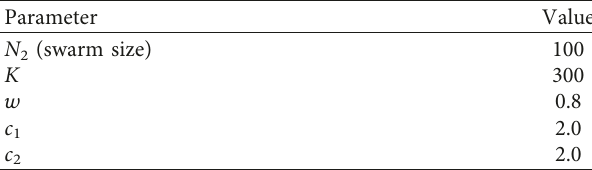
Table 3: Combinations of input variables in fuzzy